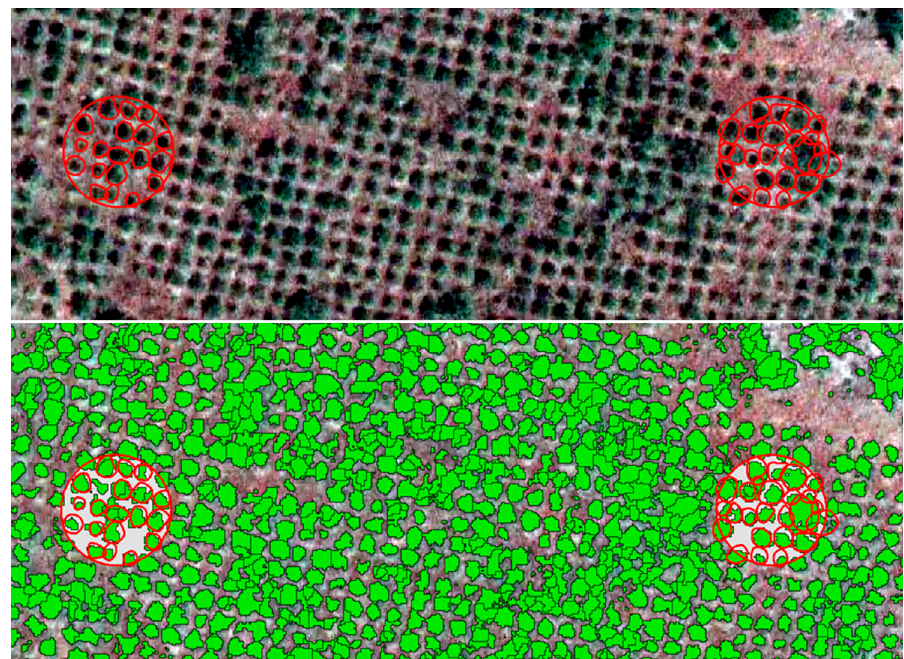
Figure 2. Comparison between field-measured crowns (red polygons, above) and segments obtained by multiresolution segmentation (green polygons, below).